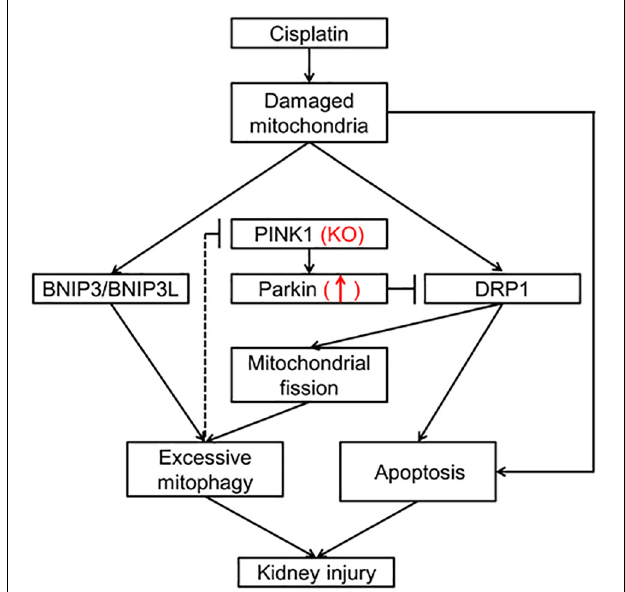
FIGURE 6 | Schematic representation of possible mechanism related to mitophagy in cisplatin-induced kidney injury in PINK1 KO rats. Cisplatin causes the mitochondrial damage of renal tubular epithelial cells, which induces BNIP3/BNIP3L-mediated mitophagy, DRP1-mediated mitochondrial fission and apoptosis leading to kidney injury. And the excessive mitophagy may have negative feedback inhibition effect on the expression of PINK1 and Parkin and result in the down-regulation of PINK1 and Parkin in WT rats. In PINK1 KO rats, PINK1 deficiency causes a compensatory increase of Parkin and significantly inhibits the up-regulation of DRP1, which regulates mitochondrial fission and apoptosis, and therefore to inhibit the excessive mitophagy and overall kidney